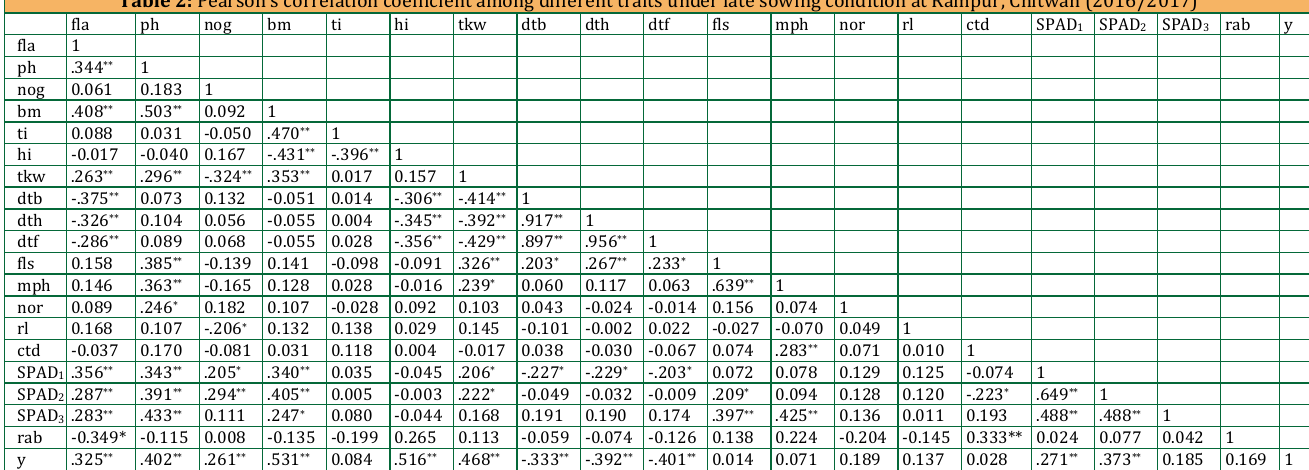
Table 2: Pearson’s correlation coefficient among different traits under late sowing condition at Rampur, Chitwan (2016/2017) fla ph